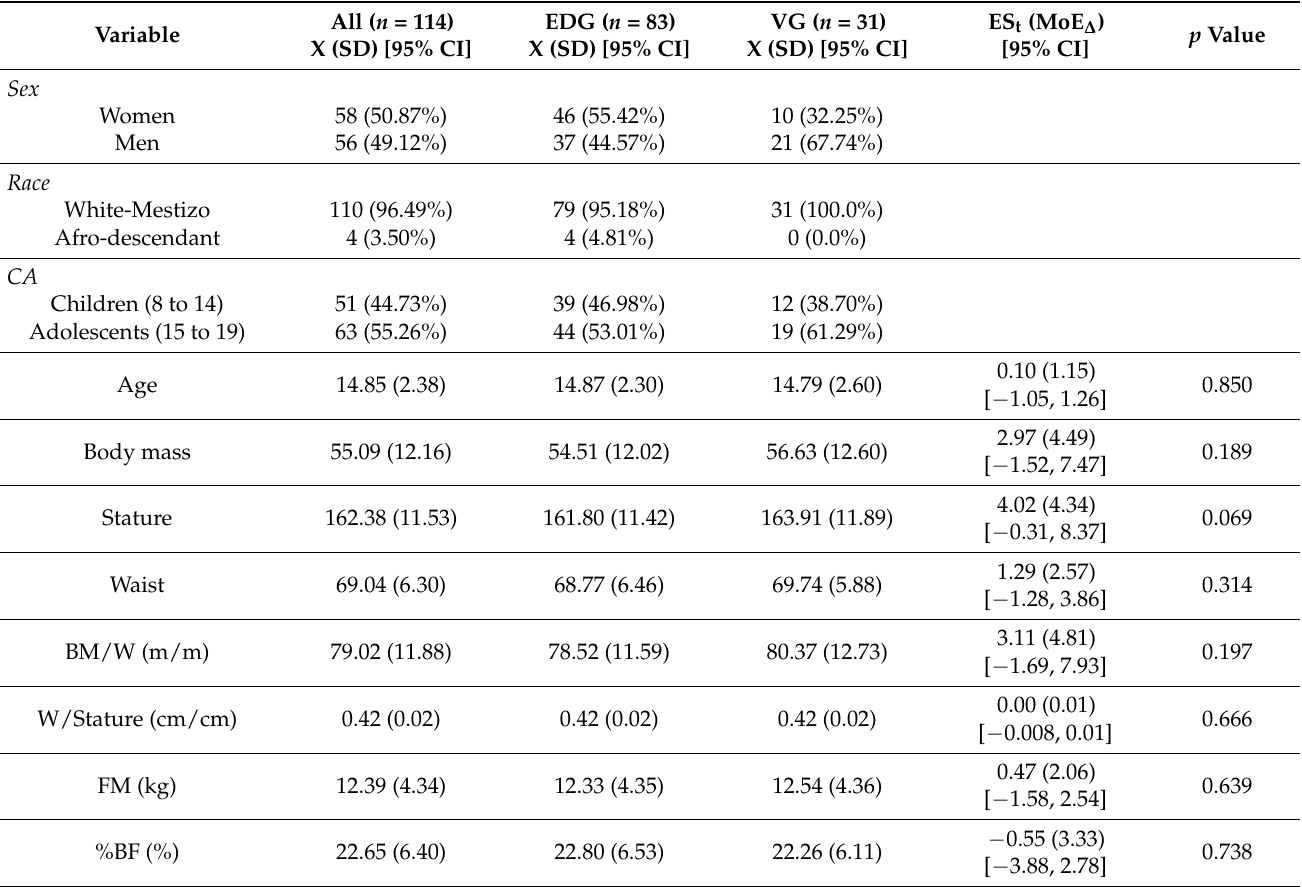
Table 1. Characteristics of the study population.